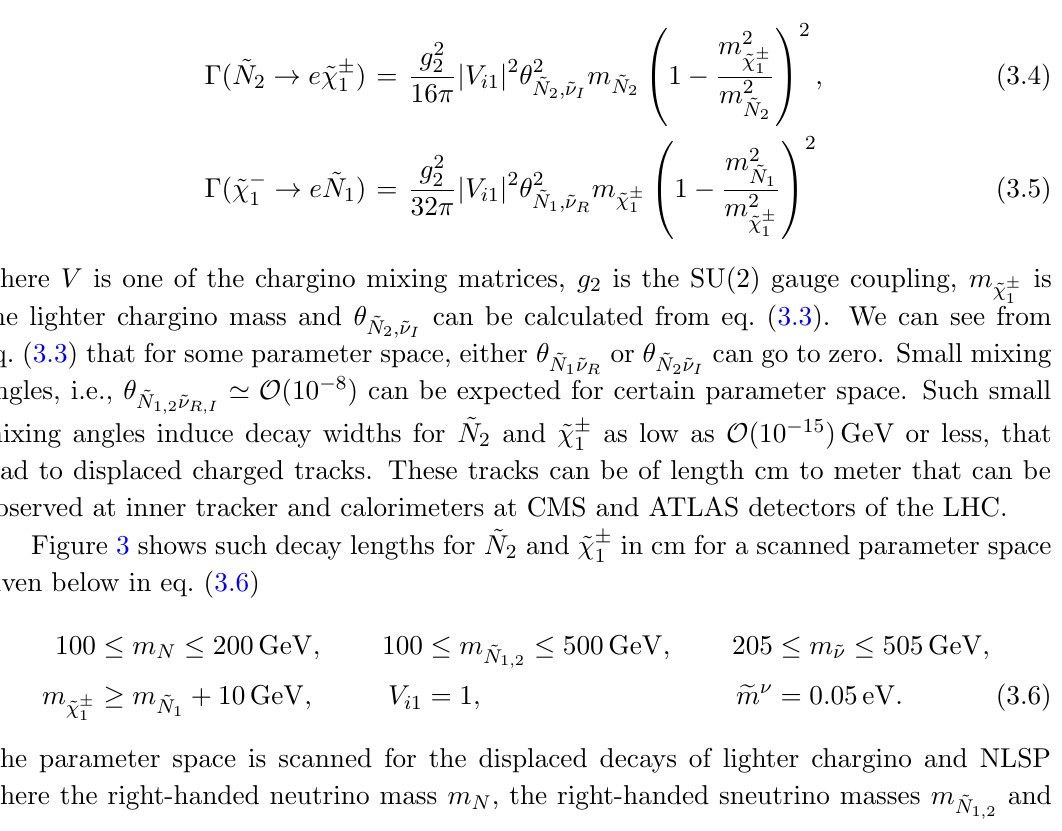
Figure 3. The displaced decay lengths of ~ N 2 and ~ (cid:31) (cid:6) be probed at the